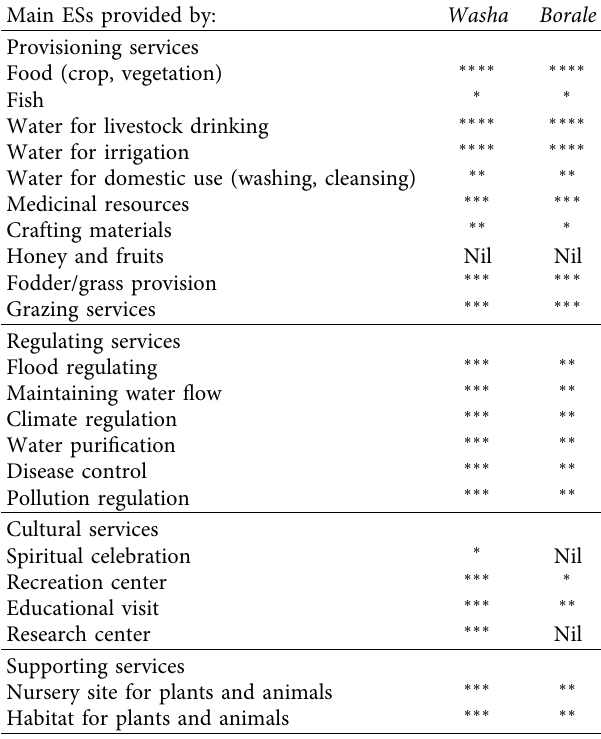
Table 9: The relative importance of ESs provided by wetlands using the perception of all participants. Main ESs provided by: Washa Borale Provisioning services Food (crop, vegetation)